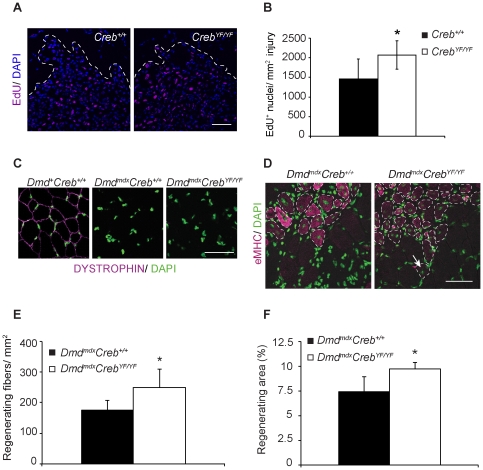
CREB promotes proliferation and muscle regeneration in mice.A) EdU-positive nuclei (magenta) and all nuclei (DAPI, blue) in injured region (below dotted line) of adult male Creb+/+ and CrebYF/YF mice 5 days after CTX injection with EdU delivery on days 2–4 after cardiotoxin. B) Average number of EdU-positive nuclei per injured area (mm2) in 5 fields per mouse. n = 5 mice per genotype, *, p<0.05 by 2-tailed paired t-test. C) Anti-dystrophin immunohistochemistry in gastrocnemius sections from 4-week old CREB-YF-mdx mice of indicated genotypes. Dystrophin, magenta; DAPI, green. D) Confocal micrographs of regenerating myofibers in cross-sections of CREB-YF-mdx gastrocnemius tissue from 4-week old mice visualized by embryonic myosin heavy chain (eMHC, magenta, broken outlines) and central nuclei (DAPI, green, arrow). E) Number of regenerating myofibers per area (±stdev) in fields representing an entire cross-section of the gastrocnemius muscle from animals of the indicated genotypes (4-week old). n = 6 DmdmdxCreb+/
+, 5 DmdmdxCrebYF/YF; *, p<.05. F) Percent regenerating myofiber area (± stdev) in gastrocnemius tissue. n = 3 DmdmdxCreb+/
+, 4 DmdmdxCrebYF/YF; *, p<.05. Bars, 50 µm.